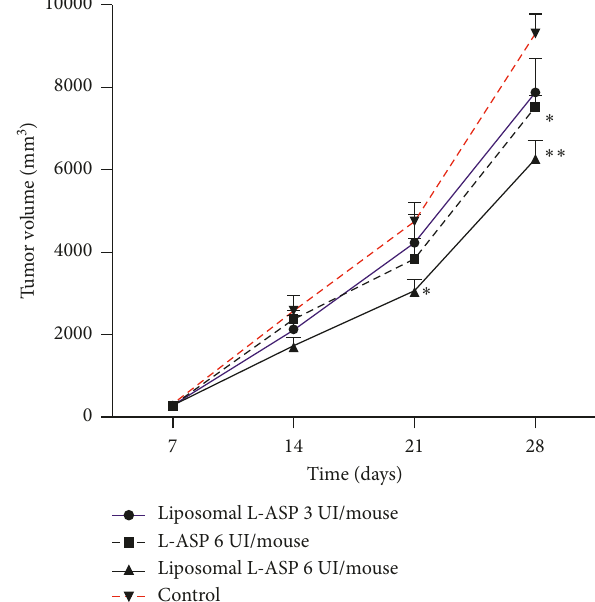
Figure 4: Tumor growth after treatment with free L-ASP or lipo- somal L-ASP. BALB/c mice harboring tumors induced by LLC cells were treated with either free L-ASP (6UI/mouse) or encapsulated L- ASP liposomes at either 6UI/mouse or 3UI/mouse ( n � 6). Lipo- some-entrapped L-ASP at both doses 6UI/mouse and 3UI/mouse significantly inhibited tumor growth after 28days compared with the negative control (blank liposome) ( ∗∗ P < 0 . 01 and ∗ P < 0 . 05, re- spectively). Error bars represent standard error (SE). Table 4: Effects of liposome-L-ASP and free L-ASP on survival time of LLC cells bearing mice from different experimented groups (mean ± SE) ( n � 6).